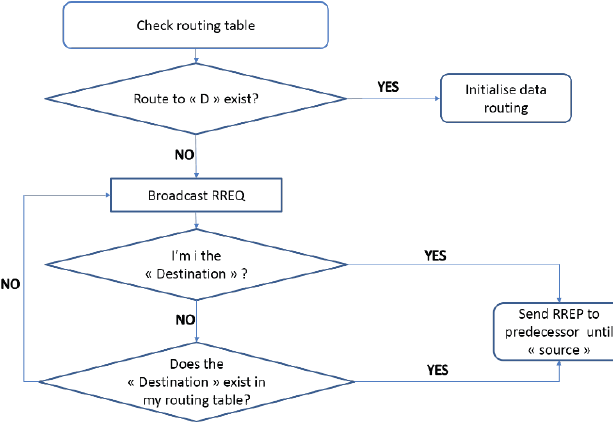
Fig. 4. AODV premise flowchart-route discovery [26].